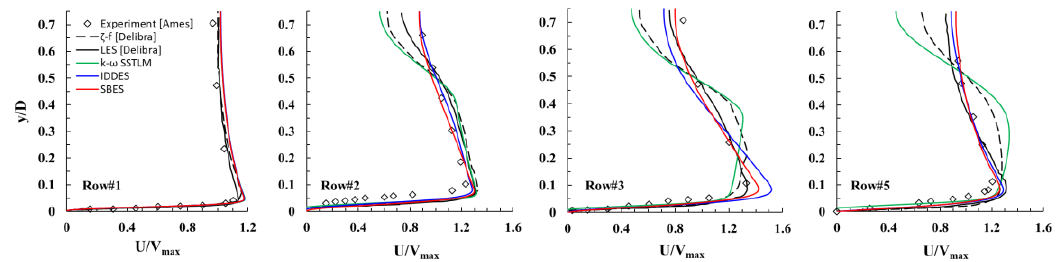
Figure 4. Time-averaged streamwise velocity profiles normalized by V max along line B at rows 1, 2, 3, and 5.